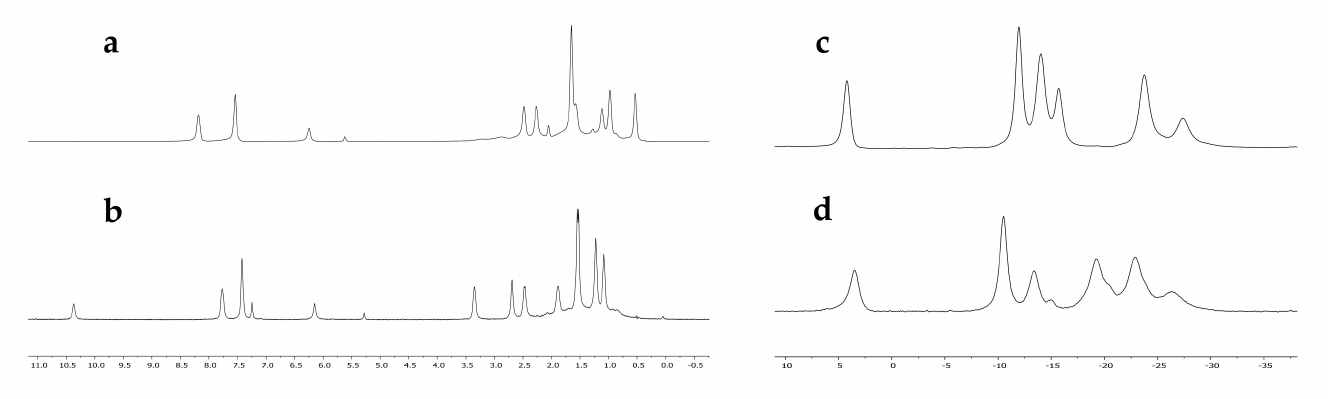
Figure 2. 1 H NMR spectra of complexes 3 ( a ) and 6 ( b ) and 11 B{ 1 H} NMR spectra of complexes 3 ( c ) and 6 ( d